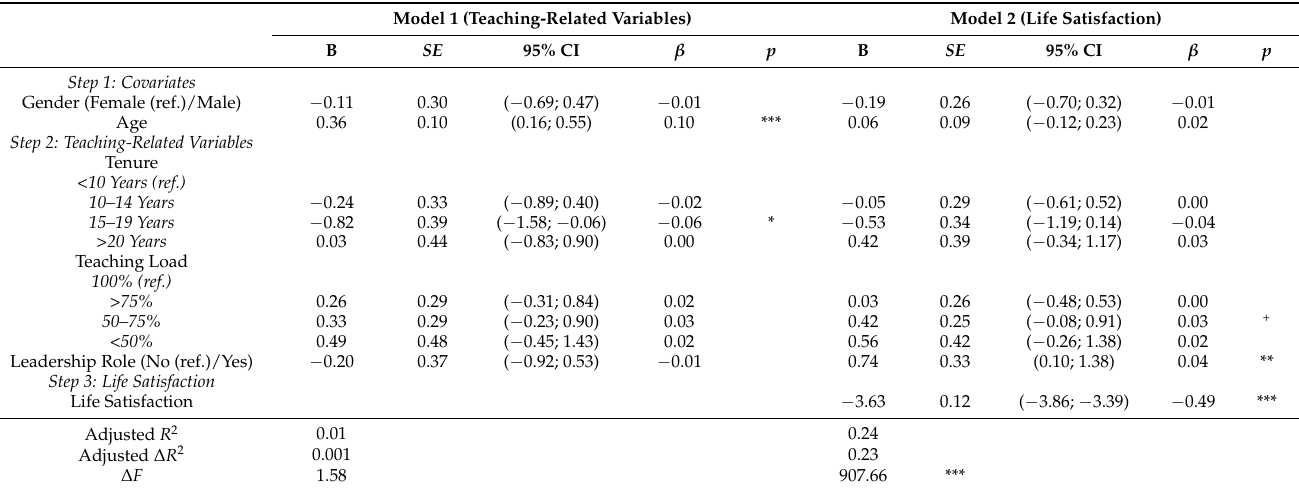
Table 8. The role of life satisfaction in psychological well-being (stepwise hierarchical regression with GHQ-12 as a dependent